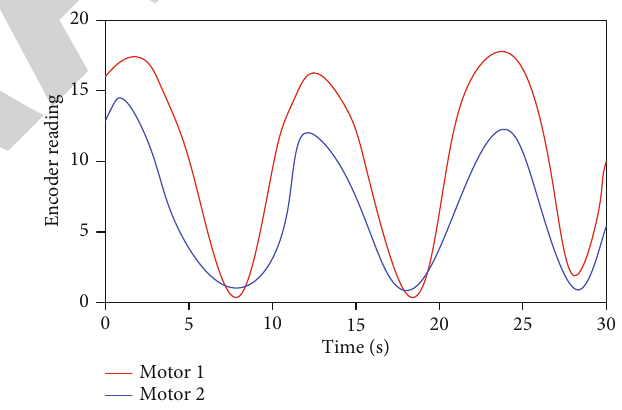
Figure 13: Motor rotation angle experiment using fuzzy impedance control